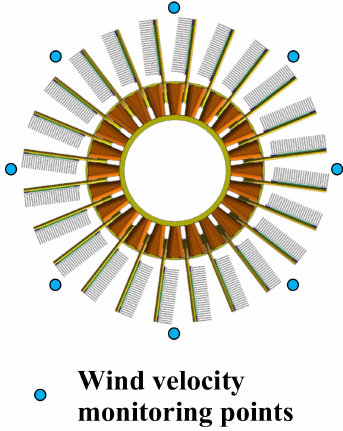
Figure 7. Wind velocity monitoring points around the